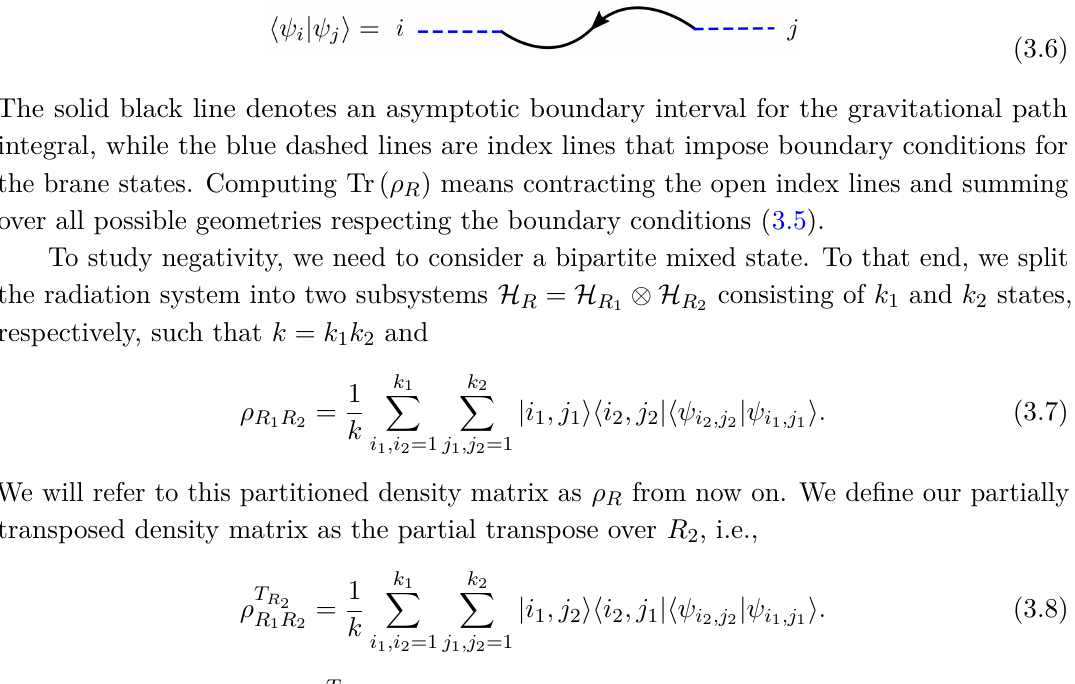
Figure 1 . Boundary conditions for ρ R and red (dotted) lines denotes states in R 2 . If we take a trace, these two boundary conditions are